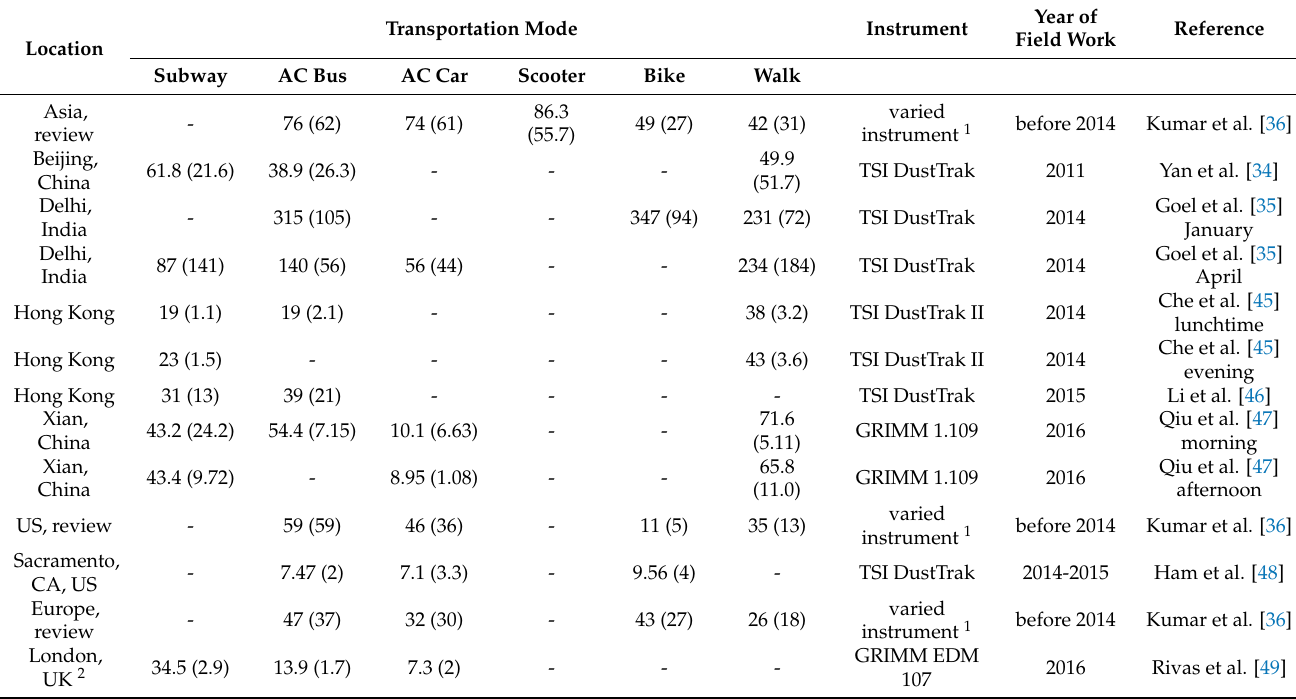
Table 3. PM 2.5 concentrations in multiple transportation modes summarized from the literature.